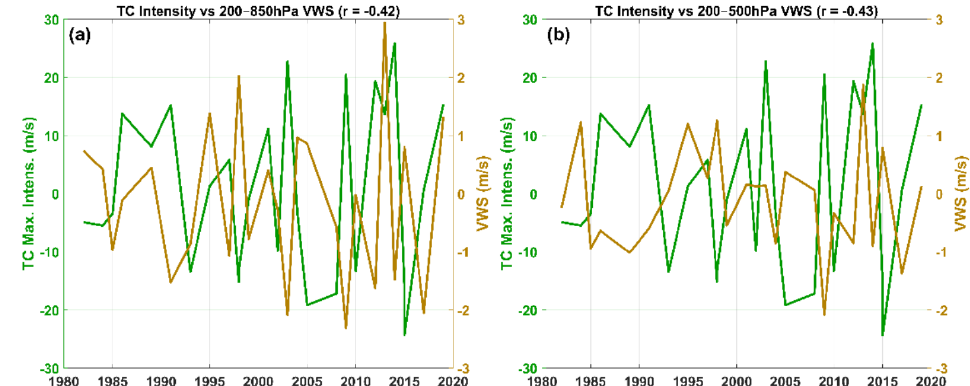
Figure 8. Plots of TC maximum intensity and VWS anomalies for 200–850 layer ( a ) and 200–500 hPa layer ( b ) for December–March over the MC. Green and red colors indicate the TC maximum intensity and VWS, respectively. The time series correlation coefficients (at zero lag) are shown on the top of the